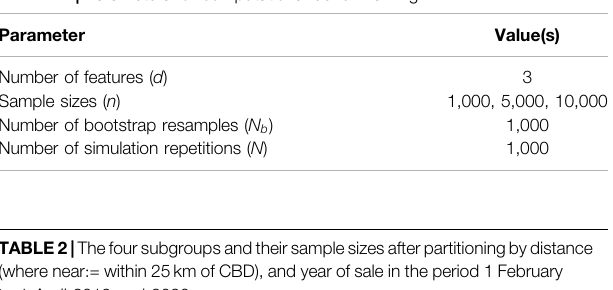
TABLE 1 | Parameters for computational benchmarking.